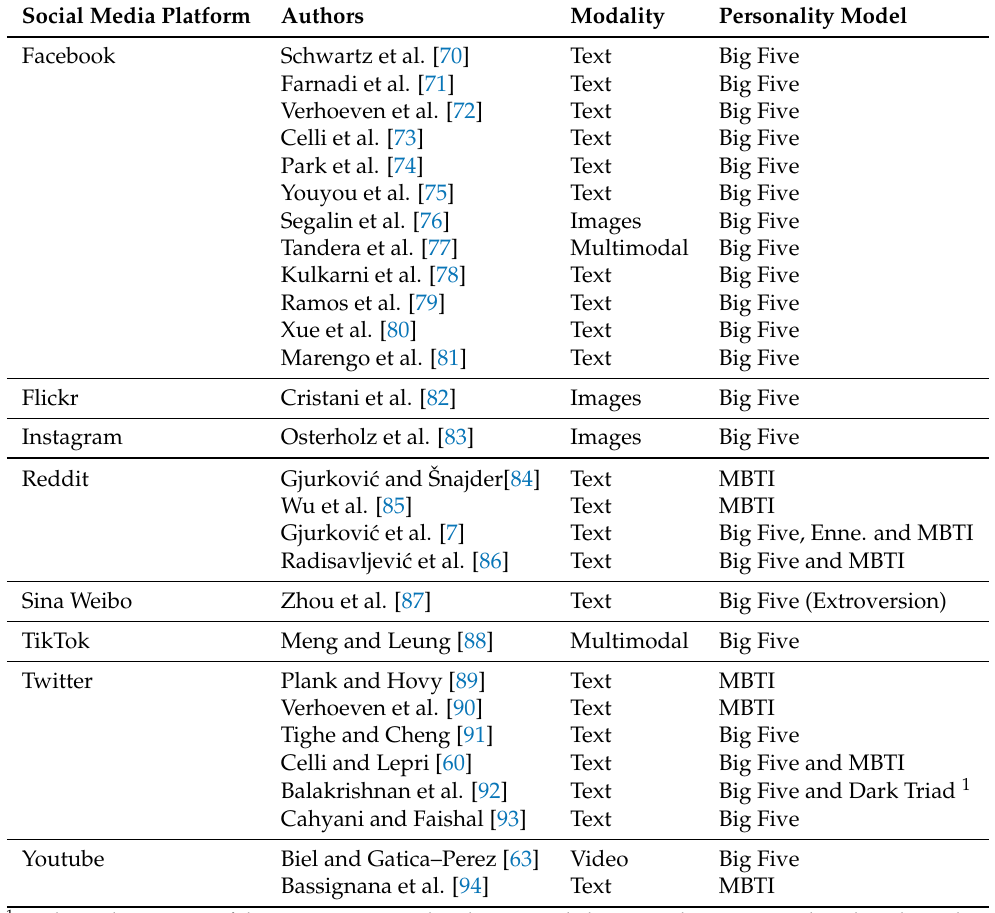
Table 1. A non-exhaustive overview of various personality computing works that utilize social media platforms as a source of data. Different to our work, most of the listed research tends to focus on a single personality model, most often the Big Five